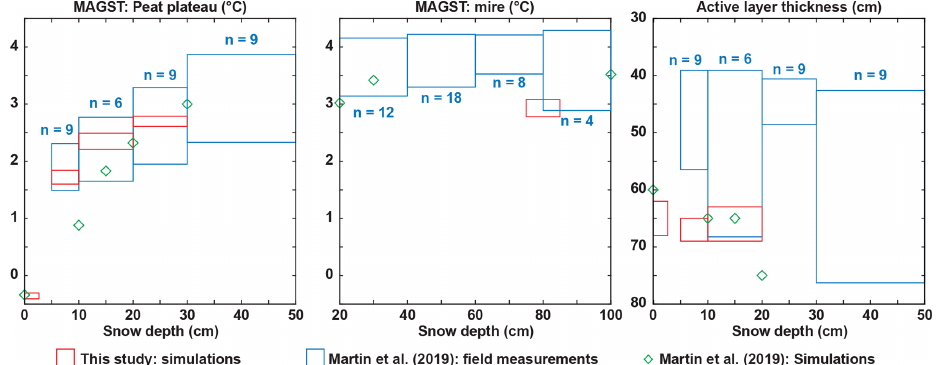
Figure A1. Mean annual ground surface temperature (MAGST) and active layer thickness as they are simulated in this study and in Martin et al. (2019) compared to the field measurements from Martin et al. (2019) for the same region. Values indicated with the letter n correspond to the number of field observations in Martin et al. (2019). The snow ranges on the x axis are those used for the modeling work of the present study. Observations from Martin et al. (2019) have been distributed in these ranges for comparison. Vertically, MAGST and ALT values span over the mean ± 1 standard deviation range for both observations (variability among observations) and simulations (variability among the tiles of a simulation).